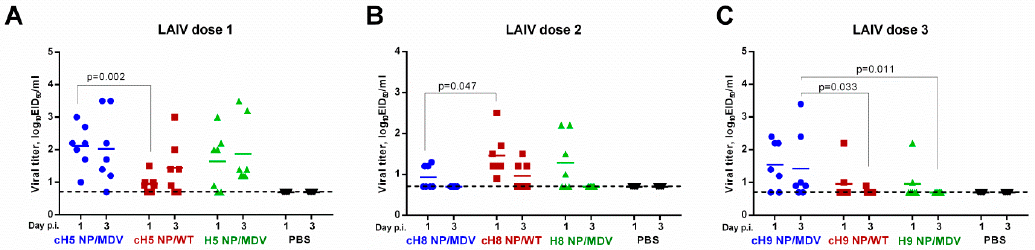
Figure 4. Replication of LAIV viruses in the upper respiratory tract of immunized ferrets after the first ( A ), second ( B ) and third ( C ) vaccine dose.